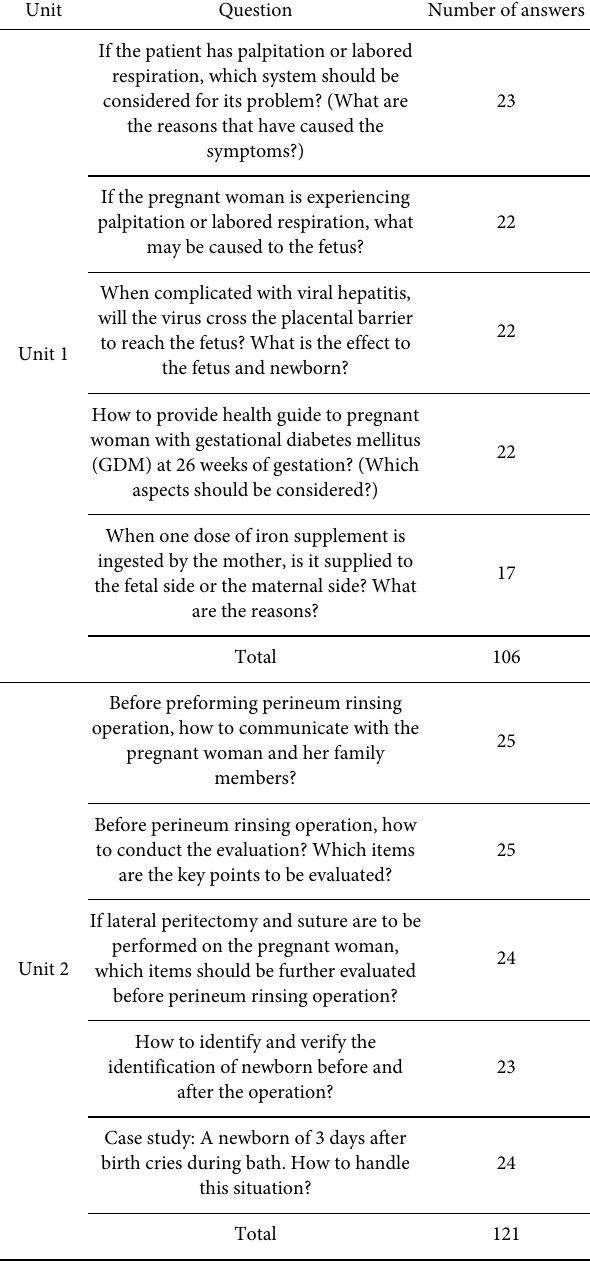
Table 2 Open-ended questions and the number of answers to each question.